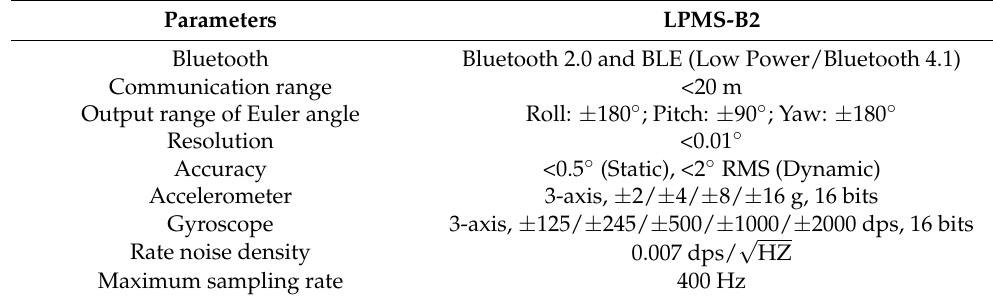
Table 1. LPMS-B2 main performance parameters.